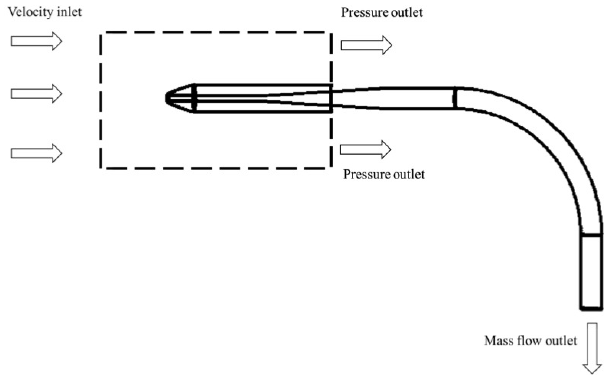
Figure A1. Model domain and boundary conditions for the com- putational fluid dynamic modeling of the CVI inlet, used as a sub- isokinetic inlet without